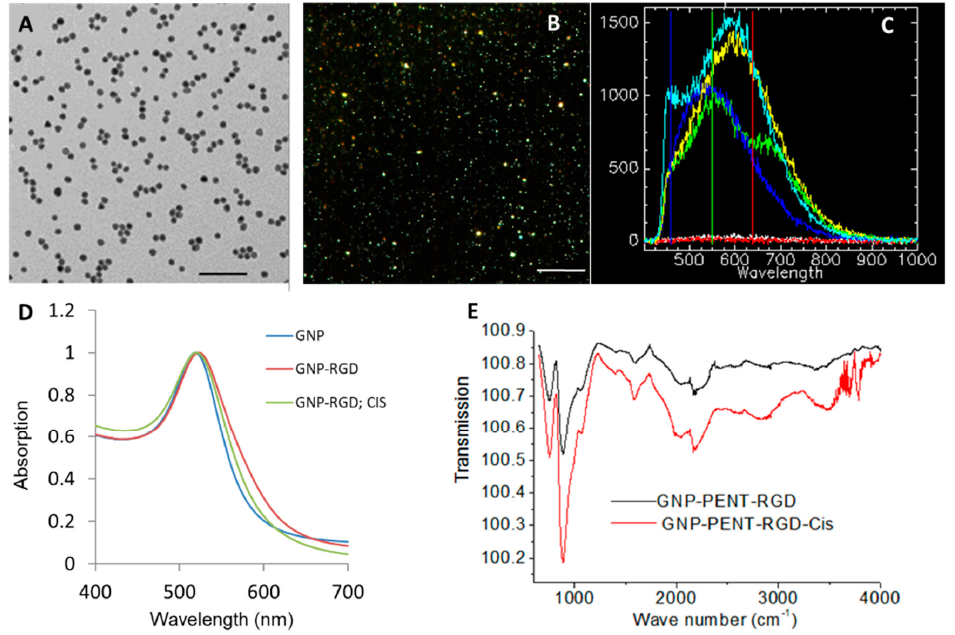
Figure 1. Characterization of gold nanoparticles (GNPs) used in this study ( A ) Transmission Electron Microscopy (TEM) of GNPs used in this study. Scale bar = 100 nm; ( B ) Hyperspectral image of GNPs. Scale bar = 20 µm ( C ) Few spectra of the GNPs from ( B ) and background spectra; ( D ) Ultra-Violet Visible (UV-Vis) spectra of GNP constructs; ( E ) Fourier Transform InfraRed (FTIR) of GNP constructs.